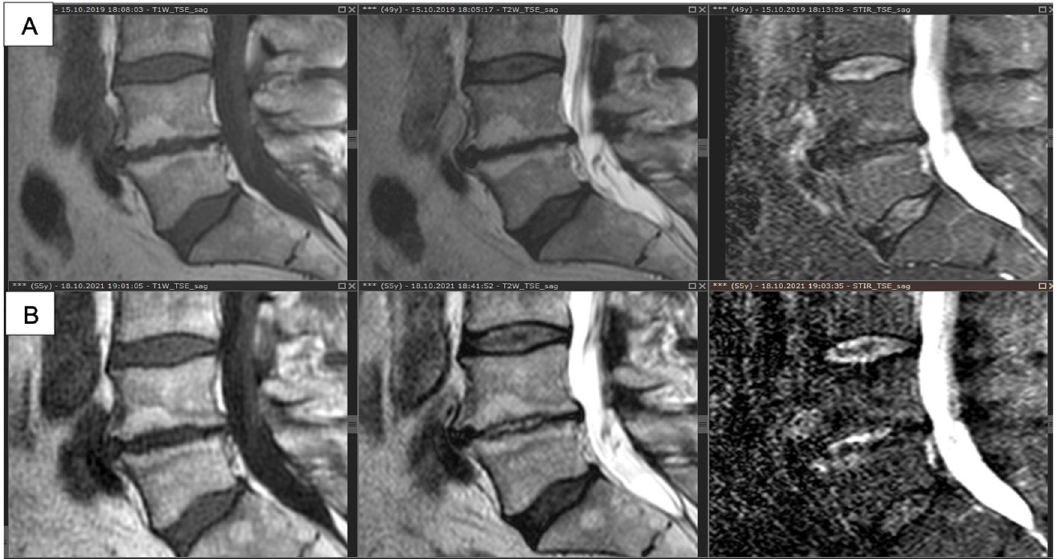
Figure 8. MRI results for a patient 53-year-old in 24 months after LRD: ( A ) before and ( B ) after punction transforaminal LRD of L4L5 disc. T1WI— left column , T2 WI— center column , STIR— right column . Change of the disc degeneration from Pfirrmann 5 to Pfirrmann 4 (T2 WI), formation of the new cartilage tissue in the center of the disc (T2 WI, STIR), change of the signal from the adjacent to the disc vertebral bone as the mark of disc metabolism shift (T1 WI).